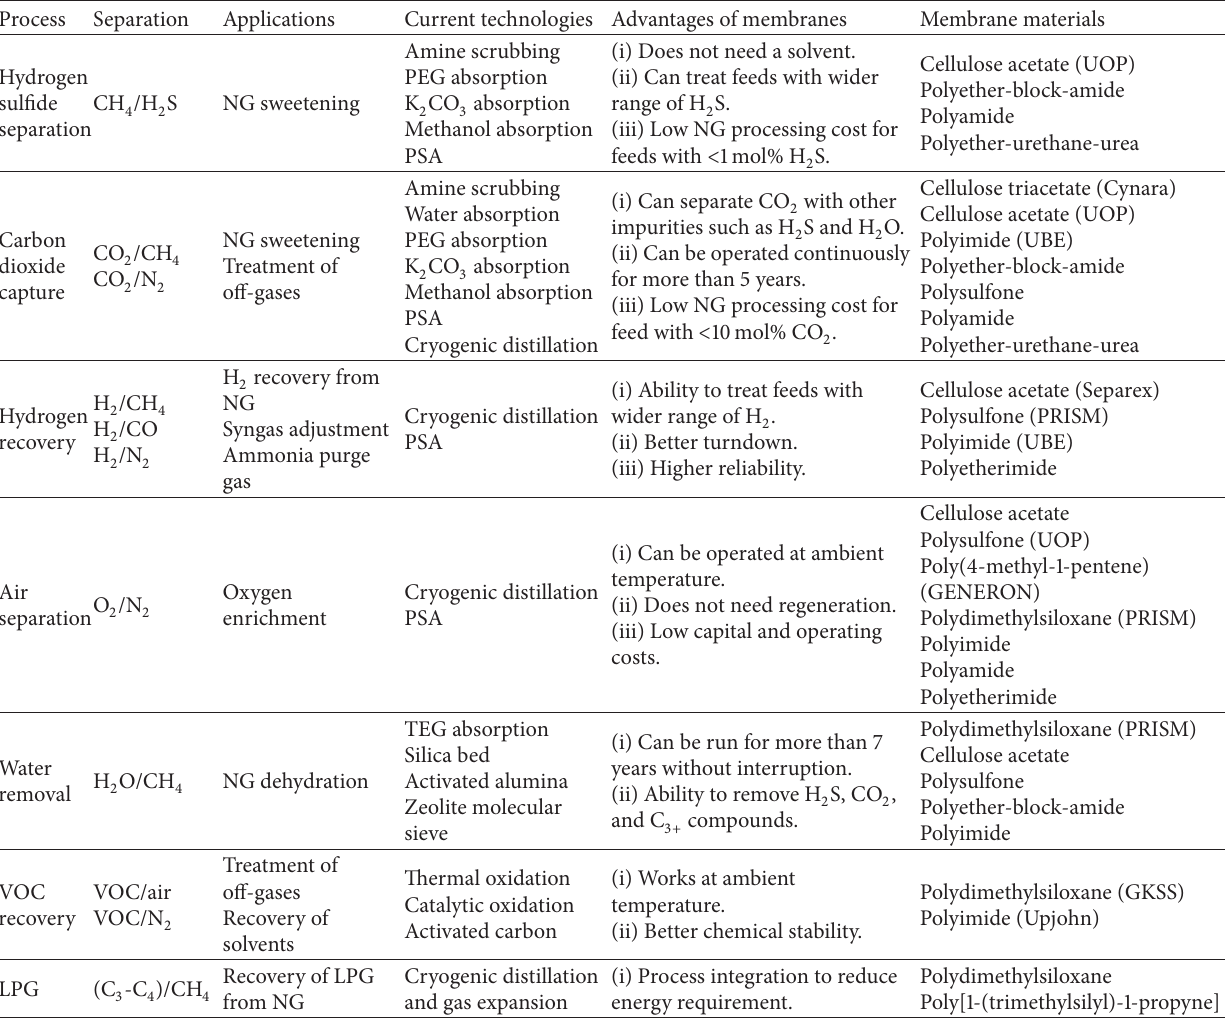
Table 16: Summary of gas separation processes in the refinery and advantages of using membranes.